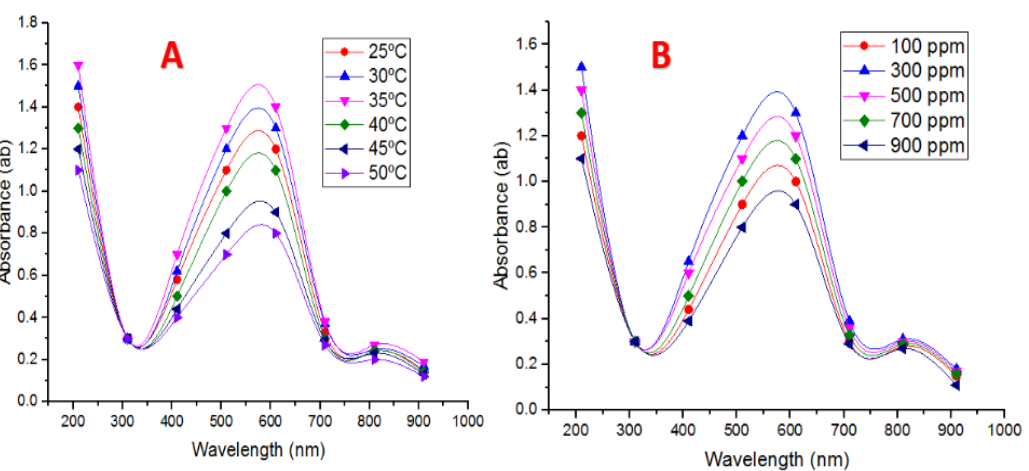
Figure 3. ( A ) UV–Vis spectra of different temperatures utilized. ( B ) UV–Vis spectra of CuSO 4 ·5H 2 O concentration used during CuNPs biotransformation by P. fluorescens MAL2.